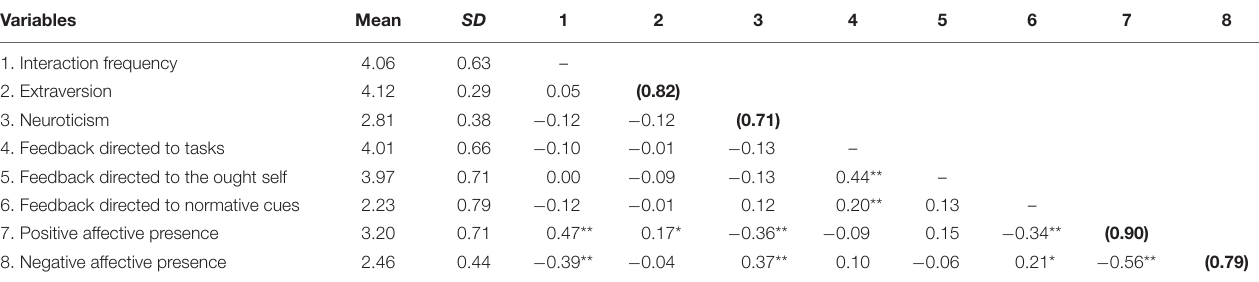
TABLE 1 | Means, standard deviations, correlations and reliabilities.